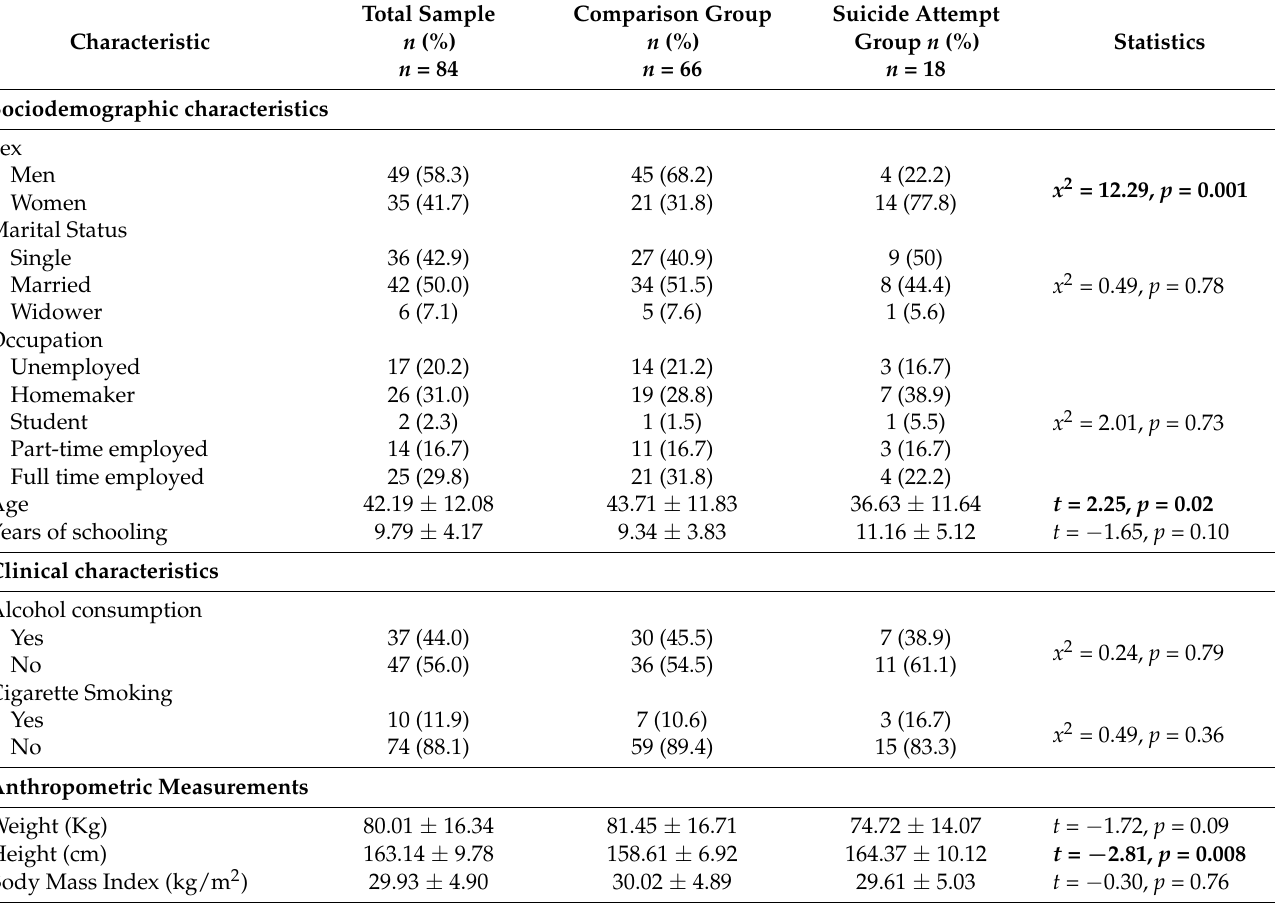
Table 1. Demographic characteristics of individuals with suicide attempts and the control